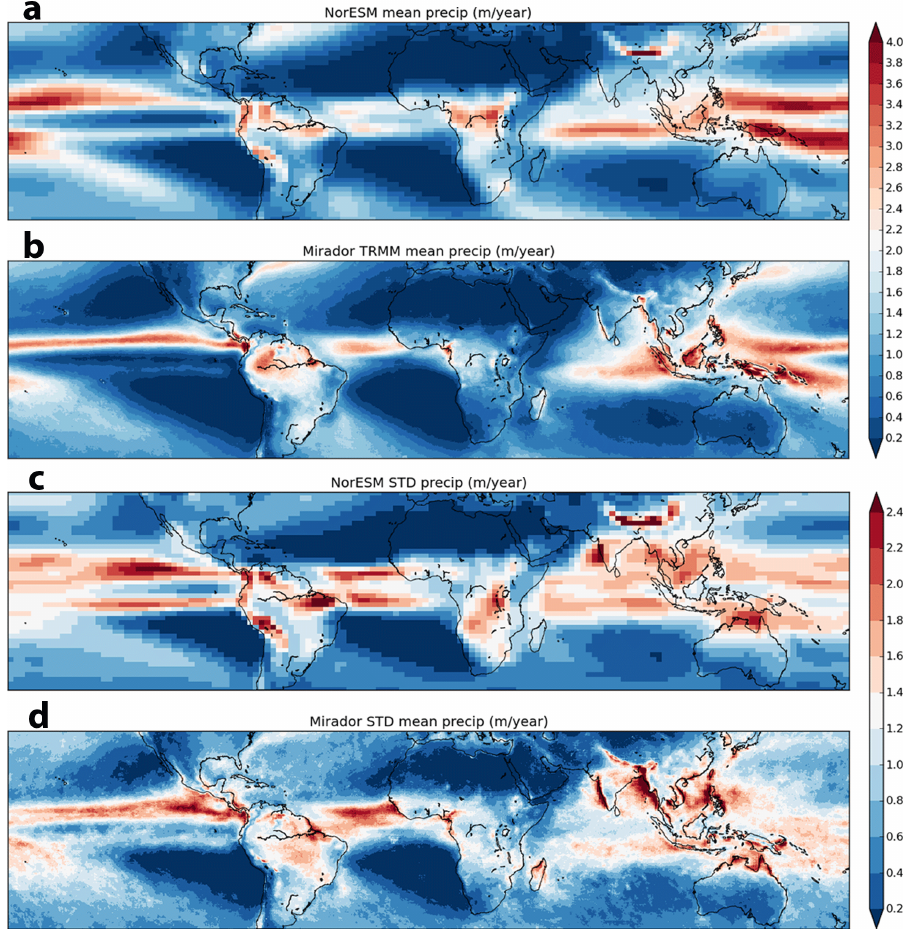
Fig. 8. (a) Simulated and (b) observation-based annual mean precipitation (myr − 1 ). In (a) , mean value of year 1976–2005 from Historical1 is shown, whereas (b) is based on Mirador TRMM version 3B43 for the period 1998–2011 (Huffman et al., 2007). Panels (c) and (d) show the monthly mean standard deviation of the fields in (a) and (b) , respectively. The fields are shown on their native horizontal resolution.